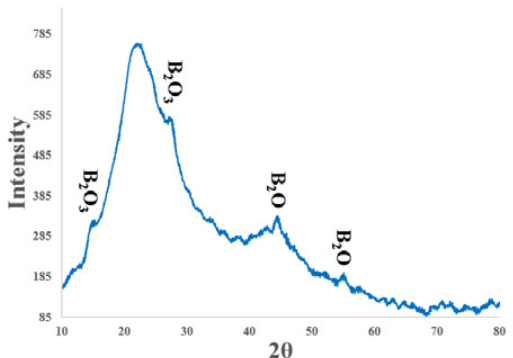
Fig. 1. The XRD pattern of the boron oxide used as the starting